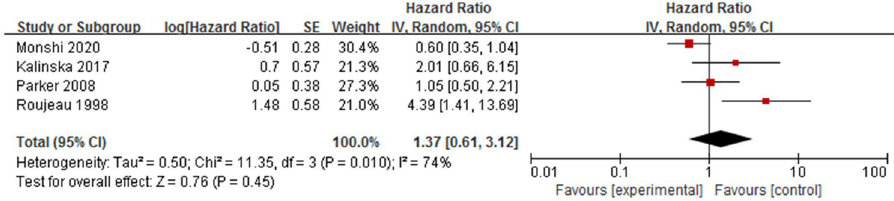
Fig 8. Forest plot of the association between disease severity and bullous pemphigoid